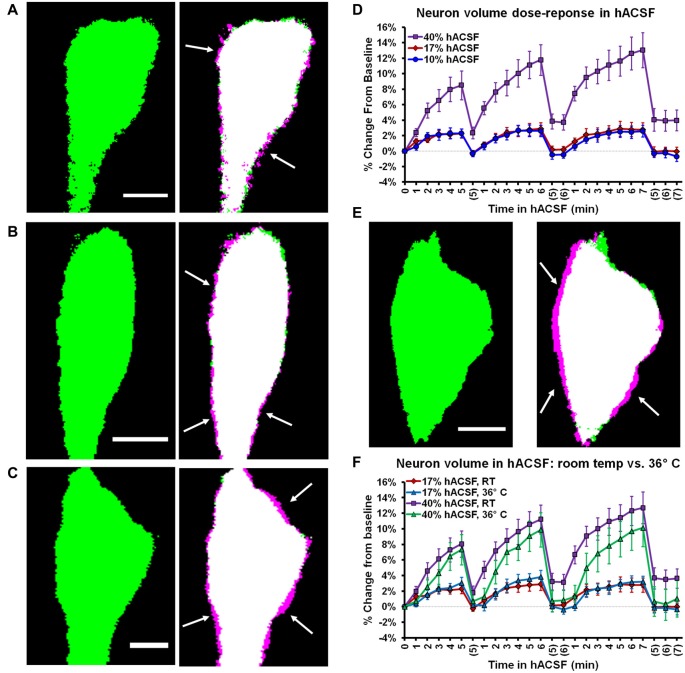
Neuronal swelling occurs across a range of hypoosmolar doses and at physiological temperature. (A–C) Volume changes observed in Thy1-eGFP neurons exposed to antagonist-free 10% (A), 17% (B), or 40% hACSF (C) at room temperature. Thresholded baseline images (green, left) are overlaid with images taken 5 min. after exposure to hACSF (right) to illustrate swelling of the soma (magenta edges, indicated by white arrows). (D) Neuronal volume as percent change from baseline during application of 10%, 17% and 40% antagonist-free hACSF doses. (E) Thresholded images of a neuron at baseline (left) and after 5 min in 40% hACSF (right), recorded at physiological temperature (36°C). As in (A–C), right image is an overlay of 5 min hACSF (magenta) and baseline (green) time point images, with white arrows indicating magenta regions of cell soma expansion. (F) Volume changes compared between neurons imaged at room temperature and 36°C, in both 17% and 40% hACSF. No significant difference was observed between the two temperatures at either dose of hACSF. Scale bars, 5 μm each for (A–C,E).